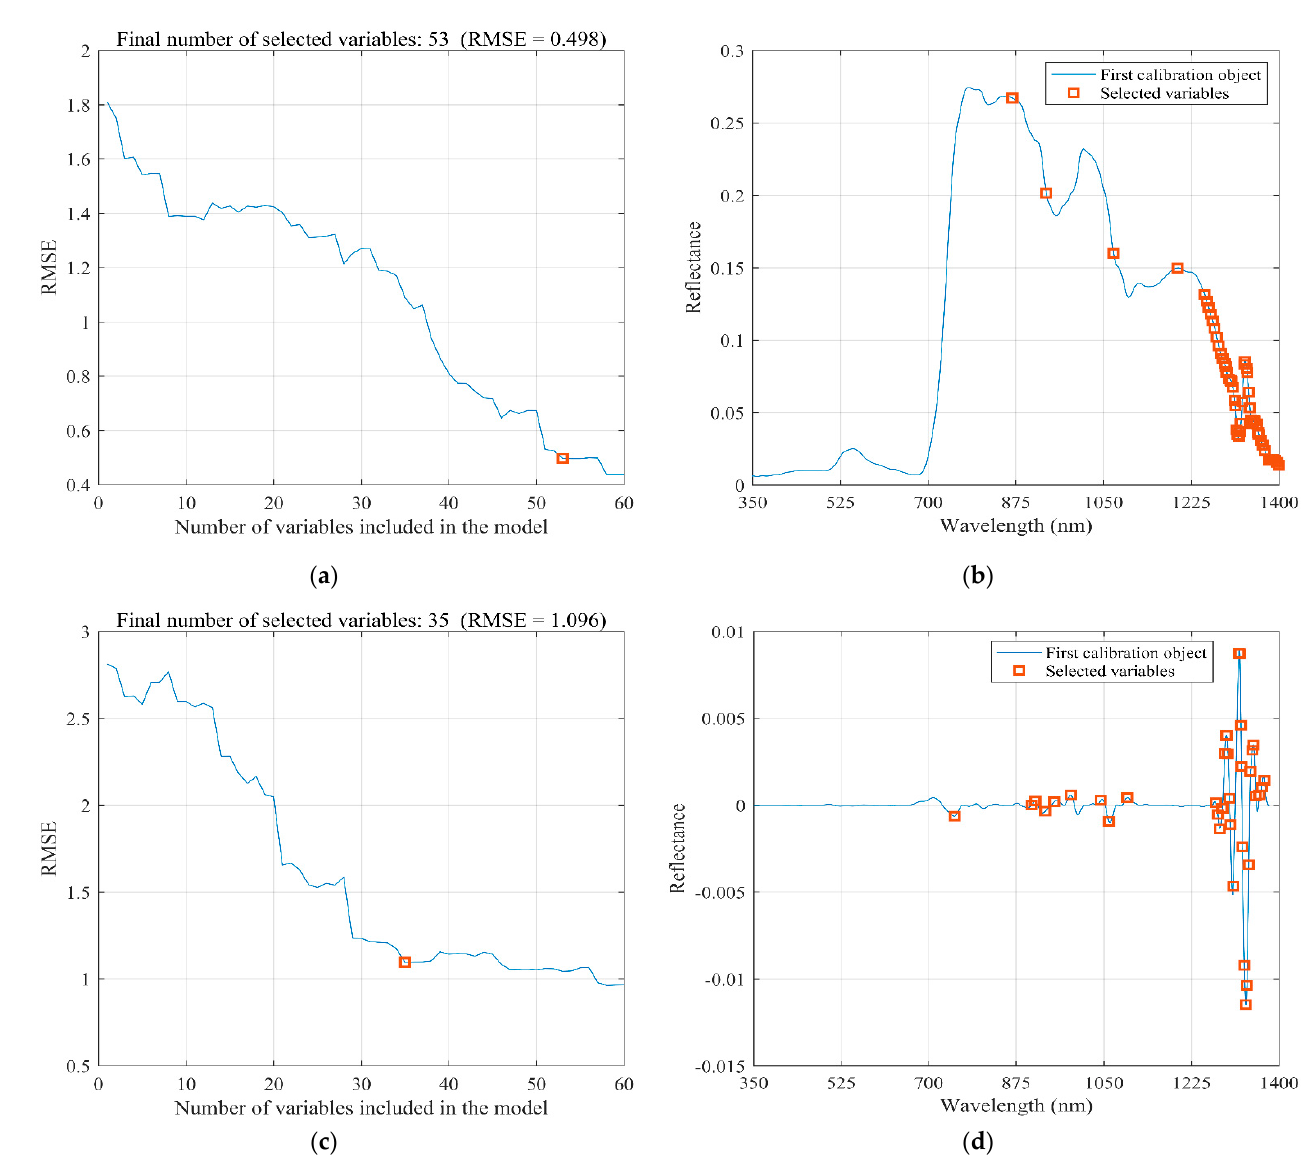
Figure 5. Optimization of the characteristic bands for the whole fertility period using the SPA algorithm: ( a ) Selection of the number of original reflectivity characteristic bands; ( b ) determination of the original reflectivity characteristic waveband; ( c ) selection of the number of first − derivative characteristic bands; ( d ) determination of the first − derivative reflectivity characteristic waveband. Table 2. Selection of characteristic wavebands of different methods.